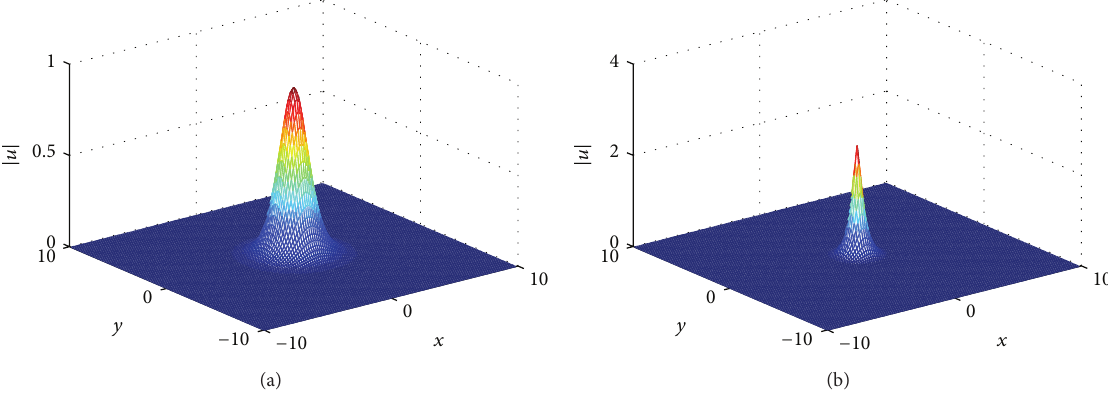
Figure 14: The lattice soliton profiles for the self-focusing quintic model: (a) for 𝜇 = 1.5 , 𝑃 = 2.4273 , (b) for 𝜇 = 5 , 𝑃 = 2.4273